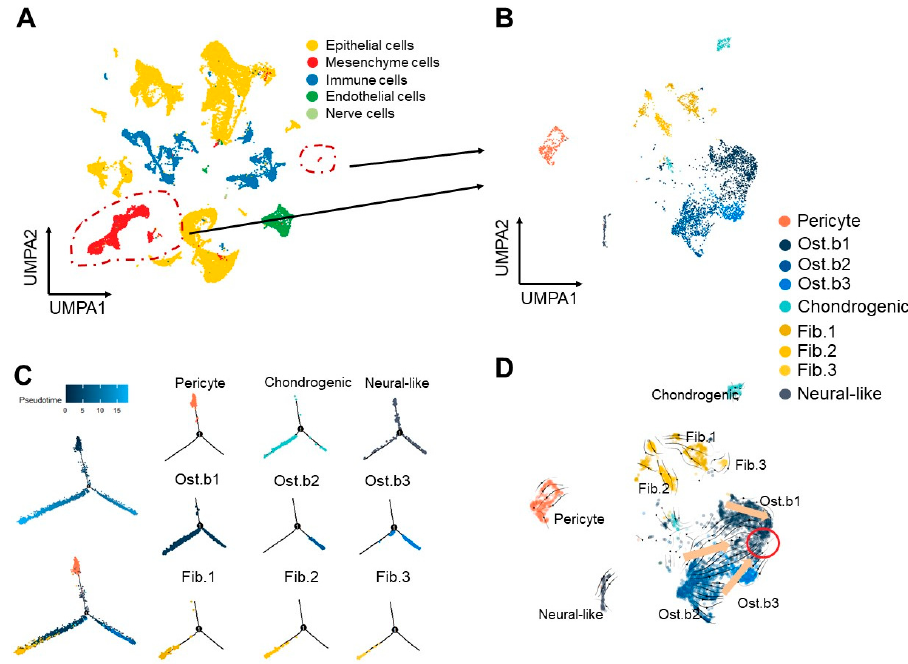
Figure 2. Mesenchymal cells show differentiation potential into osteoblasts, chondroblasts, and fibroblasts in the midpalatal suture (mouse model). ( A ) Distribution of five cell clusters in the midpalatal suture visualized using UMAP plots, including epithelial cells, mesenchyme cells, immune cells, endothelial cells, and nerve cells. The area circled by the dotted line shows mesenchyme cells magnified on the right in Figure 2B. ( B ) Distribution of 4678 re-clustered mesenchymal cells. Nine sub-clusters are visualized in total in the UMAP plots. ( C ) Pseudotime trajectory analysis showing the relationships between nine subclusters of mesenchymal cells colored by cell cluster. ( D ) RNA velocity of each cluster of mesenchymal cells calculated from unspliced and spliced transcripts colored by cell cluster.